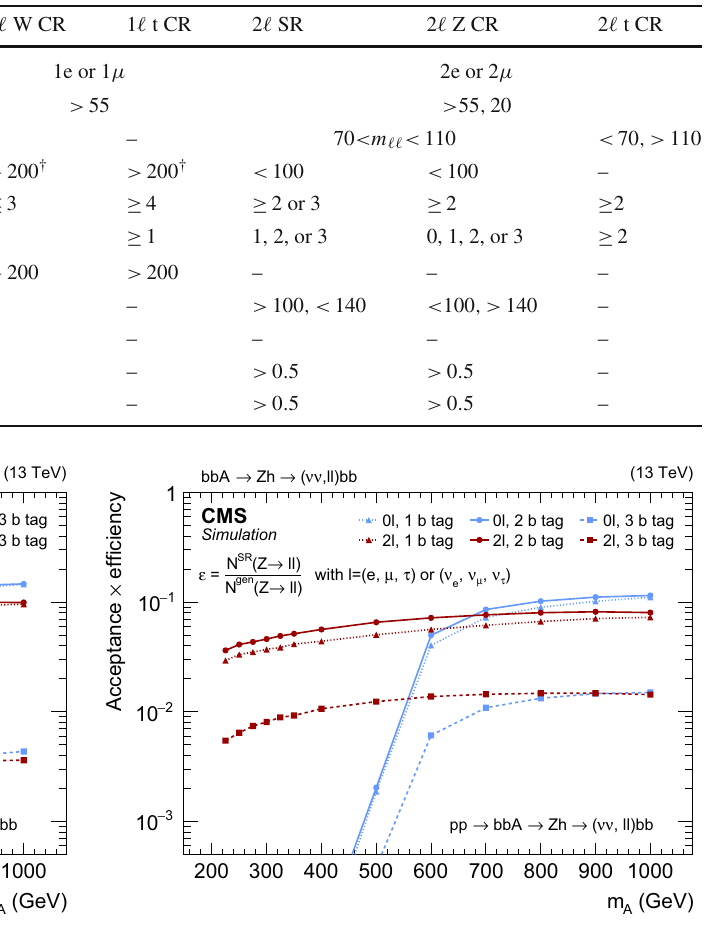
Fig. 2 Product of the signal acceptance and selection efficiency ε for an A boson produced via gluon–gluon fusion (left) and in association with b quarks (right) as a function of m A . The number of events passing